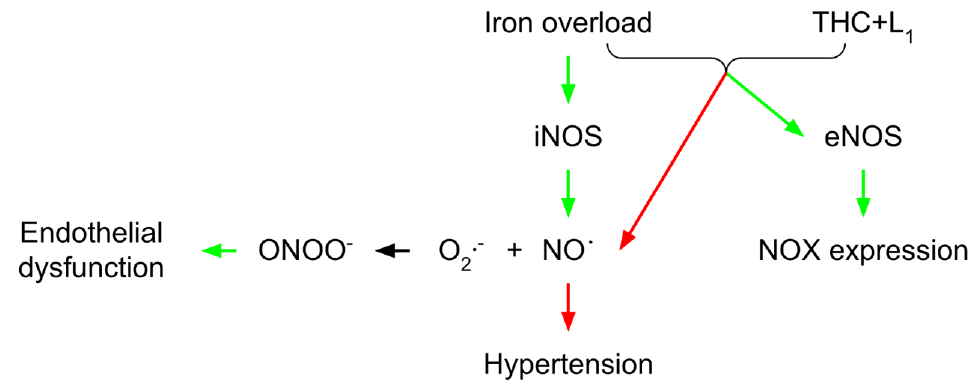
Figure 3. Vascular THC protection in conditions of iron overload. THC-mediated free radical clearance may limit iNOS induction, decreasing NO generation. THC restores endothelium protective properties by boosting eNOS and restoring vascular responses and blood pressure. THC enhanced antioxidant GSH and restored the redox status in iron-overloaded conditions. THC, tetrahydrocurcumin; iNOS, inducible nitric oxide synthase; eNOS, endothelial nitric oxide synthase; NO, nitric oxide; L 1 , deferiprone; red arrow, inhibitory effect; green arrow, stimulatory effect.